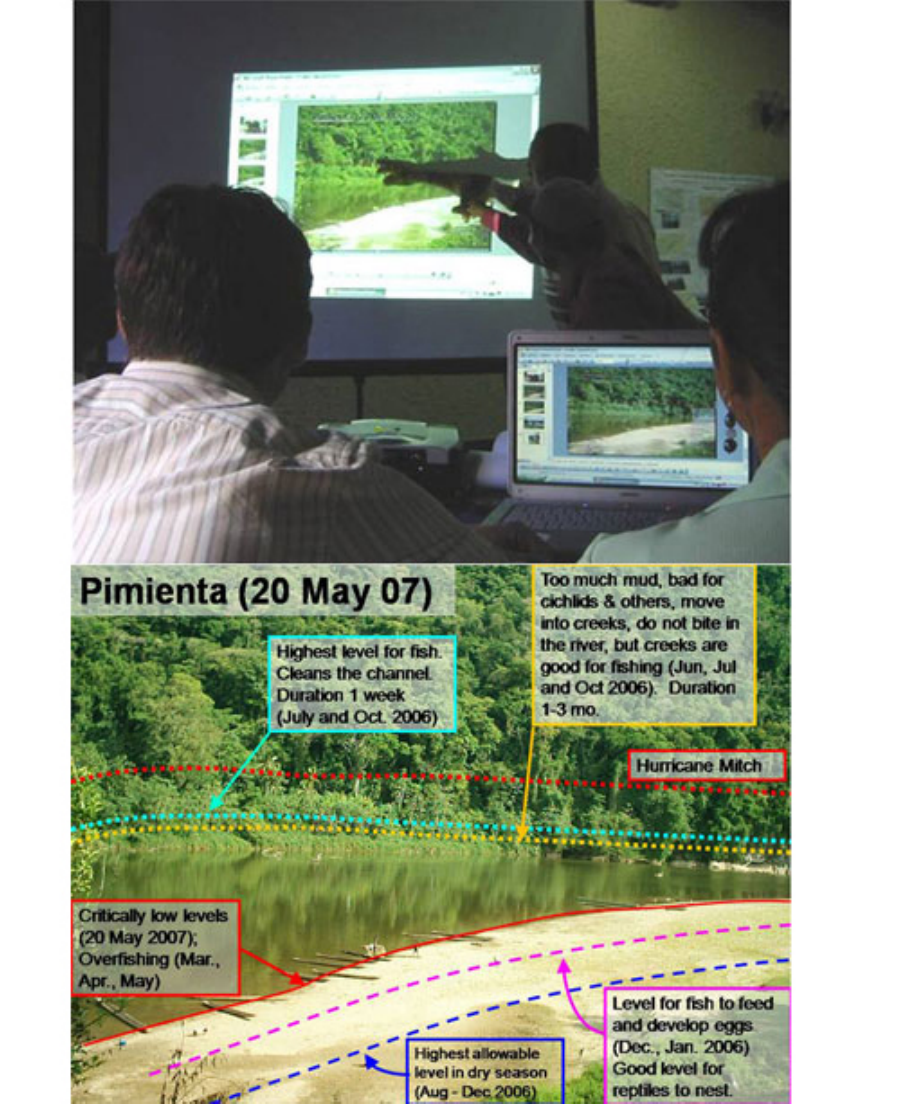
Fig. 4. Important flow levels were established in workshops with community members by annotating photographs of familiar locations along the river (top). In this case, a community member from Pimienta Village is indicating the level that Hurricane Mitch reached by pointing out a specific palm tree that he used as a visual reference during the storm. The results (bottom) helped establish the positive and negative importance of different flow levels for values of the river from the perspectives of community